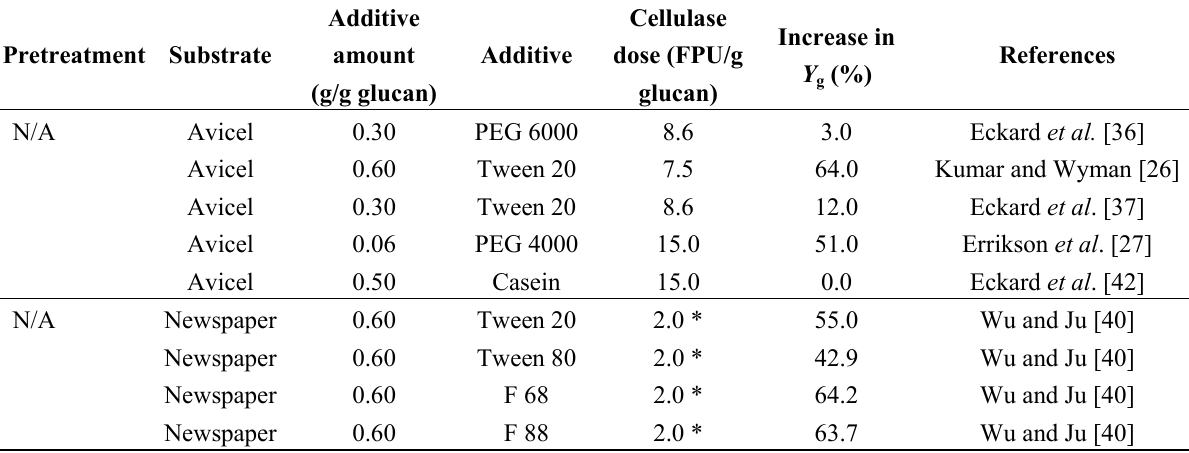
Table 1. Comparison of the effectiveness of different amphiphiles for improvement